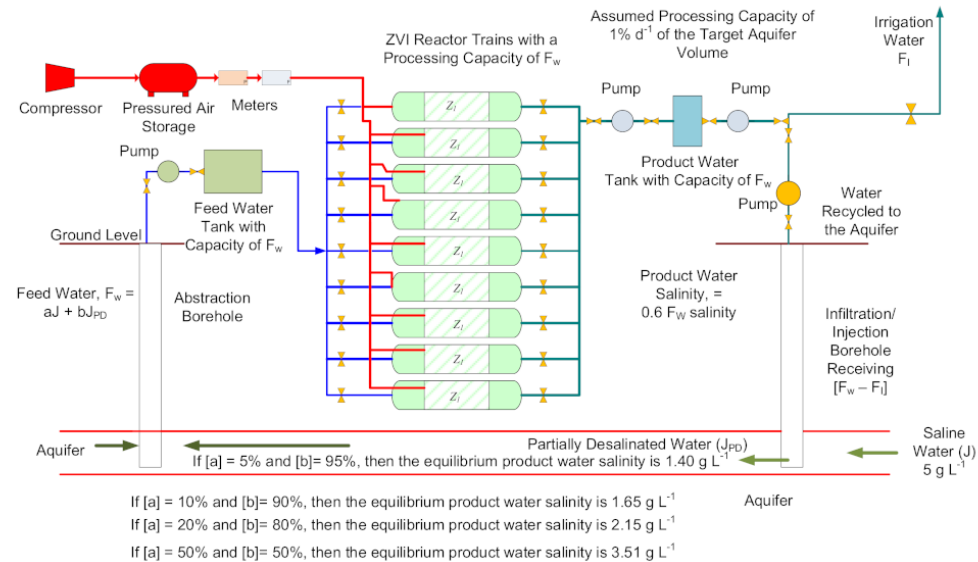
Figure 12. Schematic process flow diagram for aquifer desalination. The assumptions provided by the example numerical analysis are: (i) volume of water processed each day is 1% of the water volume enclosed by the infiltration wells (Figure 11); (ii) the aquifers normal salinity is 5 g L − 1 .